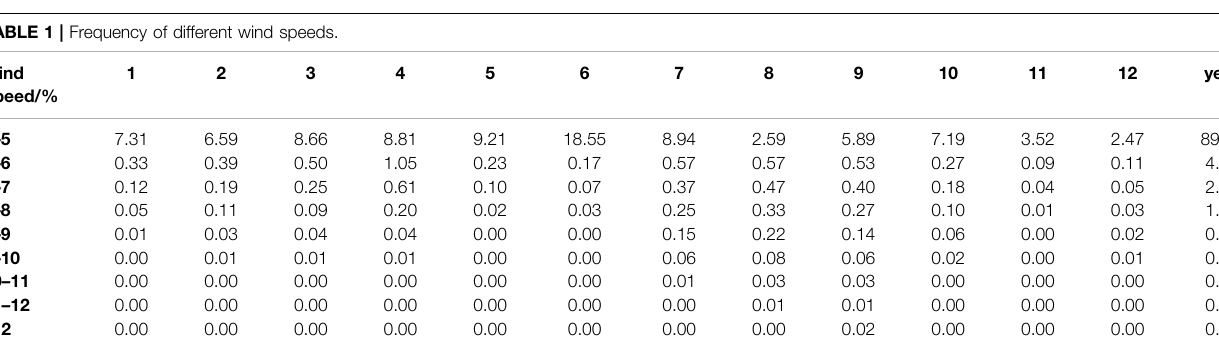
TABLE 1 | Frequency of different wind